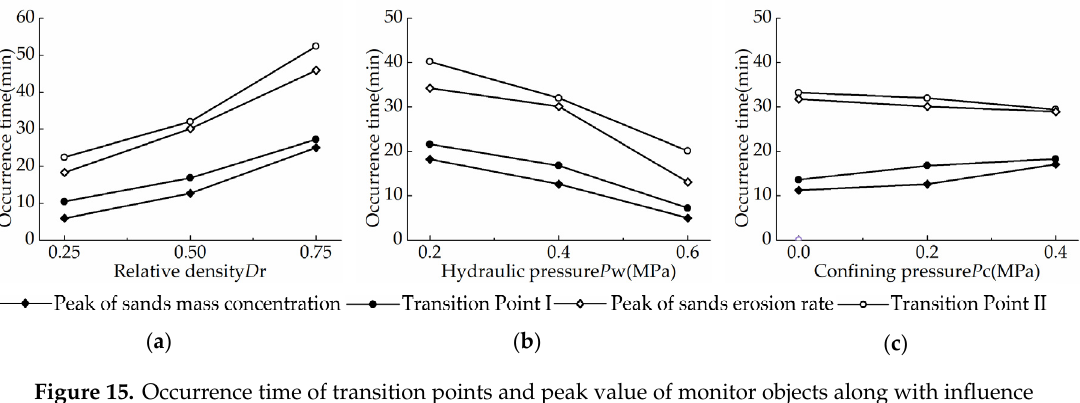
Figure 15. Occurrence time of transition points and peak value of monitor objects along with influence factors. ( a ) Occurrence time of transition points and peak value of monitor objects along with relative density; ( b ) Occurrence time of transition points and peak value of monitor objects along with hydraulic pressure; ( c ) Occurrence time of transition points and peak value of monitor objects along with confining pressure.